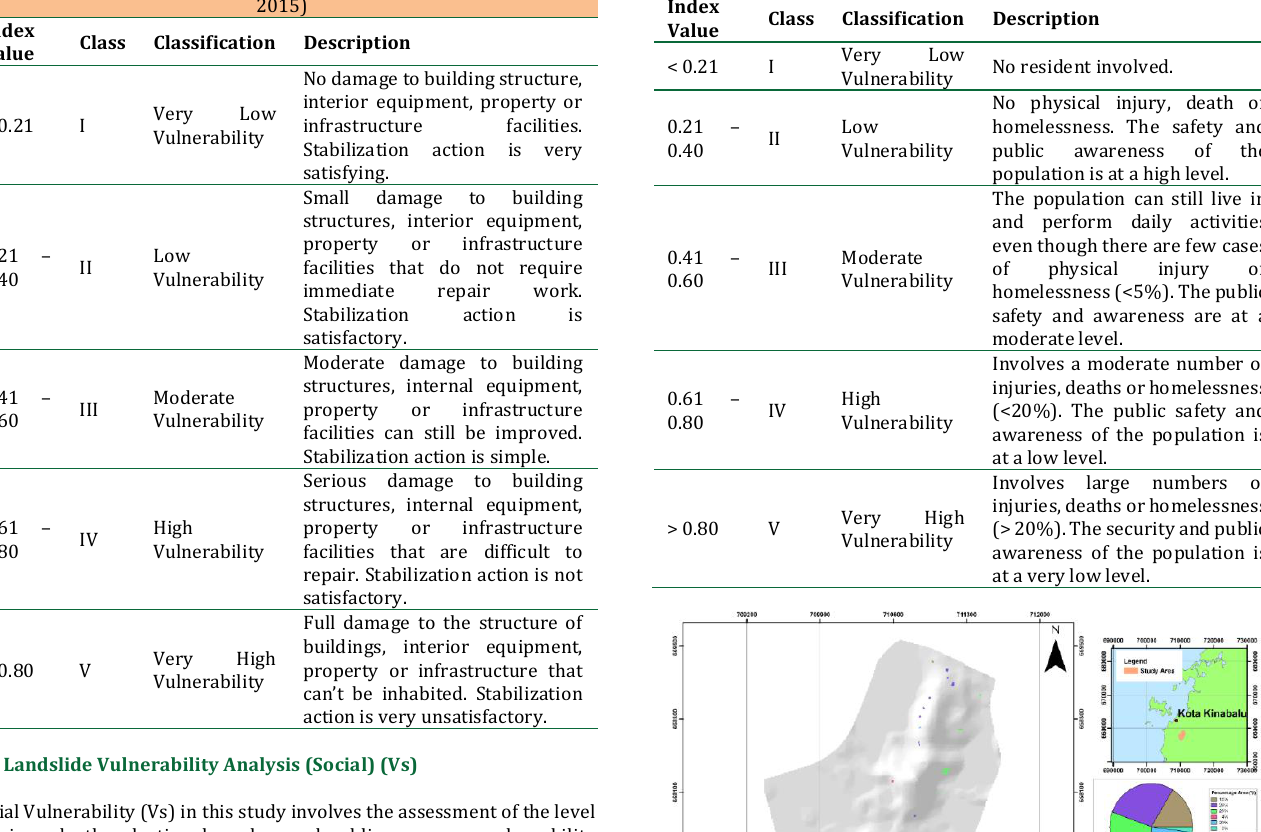
Table 1: Characteristics of Physical Vulnerability (Vp) (Rodeano, 2015)